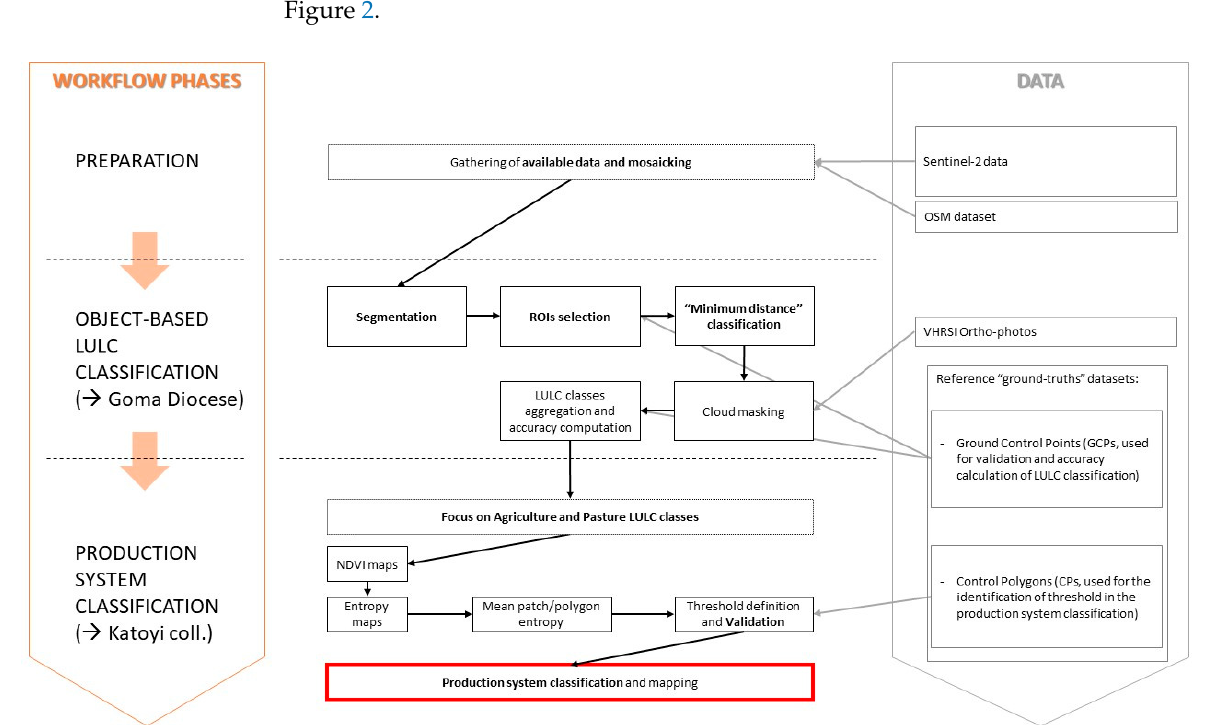
Figure 2. Workflow showing the main operations for obtaining final results in LULC acquisition from S2 multispectral